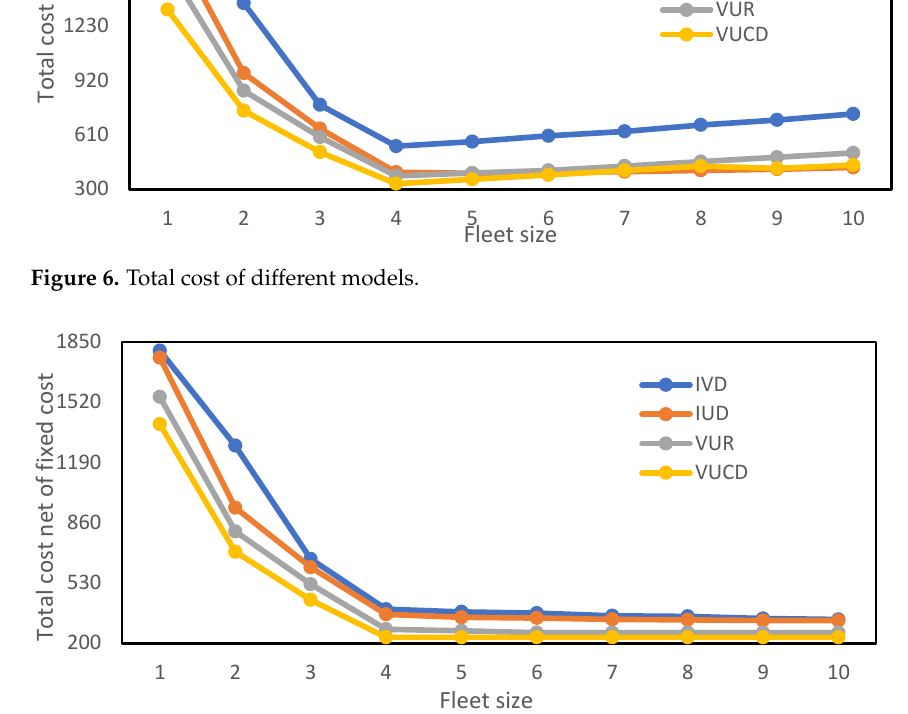
Figure 7. Total cost (net of fixed cost) of different models.